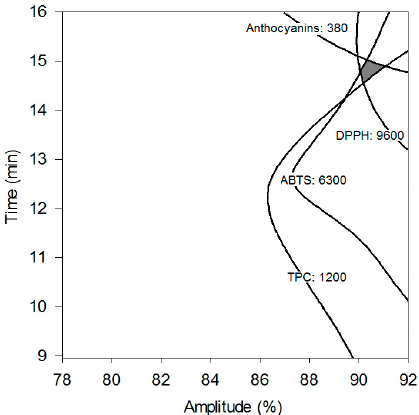
Figure 3. Superimposing contour plots for the response variables (TPC: mg GAE/100 g·dw; Anthocyanins: mg/100 g·dw; ABTS: µmol TE/100 g·dw and DPPH: µmol TE/100 g·dw) as affected by Anthocyanins: mg/100 g ¨ dw; ABTS: µ mol TE/100 g ¨ dw and DPPH: µ mol TE/100 g ¨ dw) as amplitude and time.